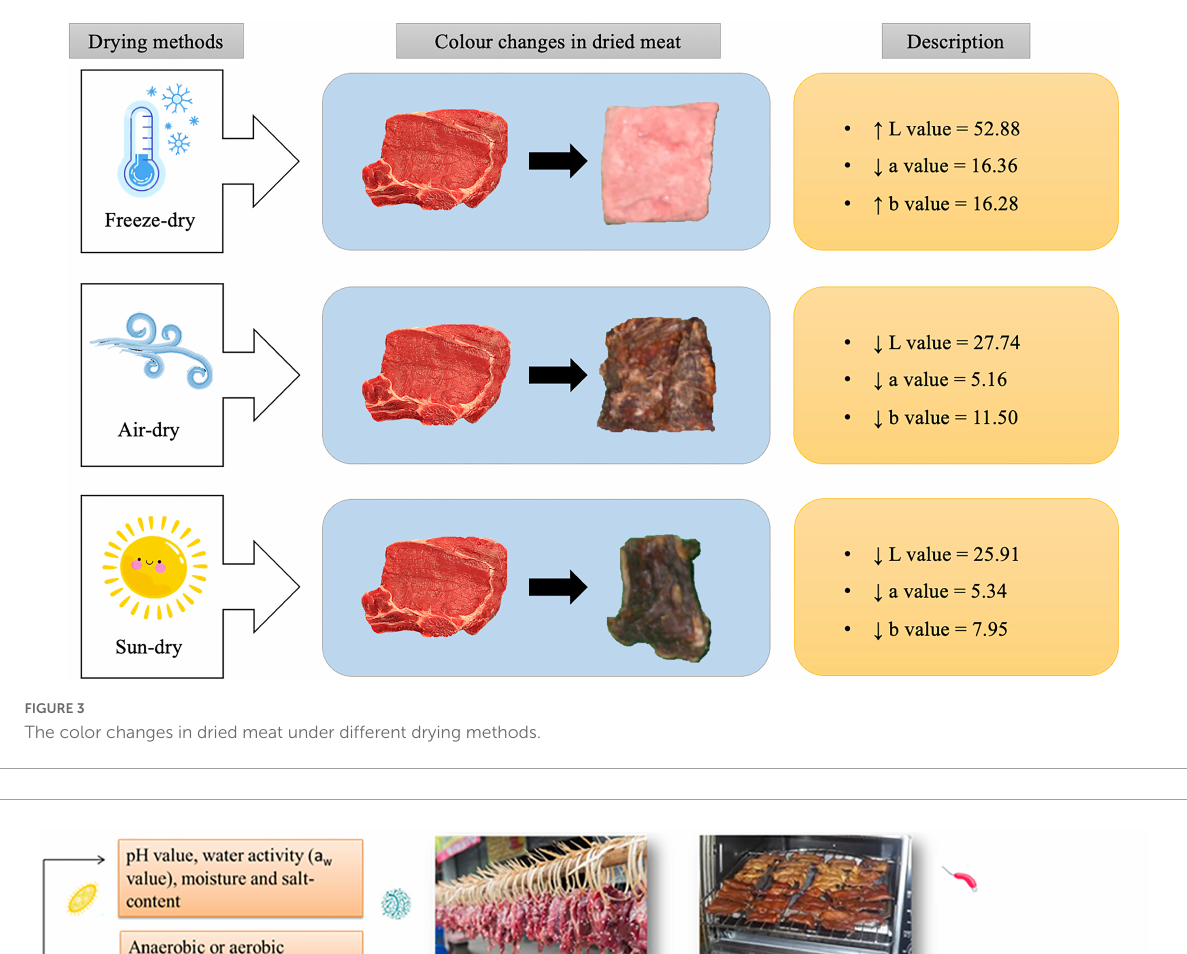
FIGURE3 The color changes in dried meat under different drying methods.